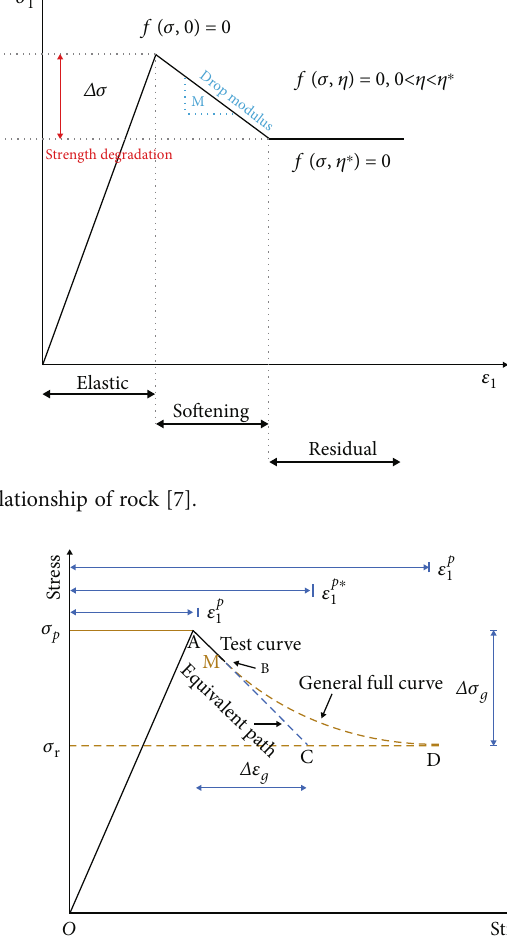
Figure 4: Diagram of soft coal residual strength estimation